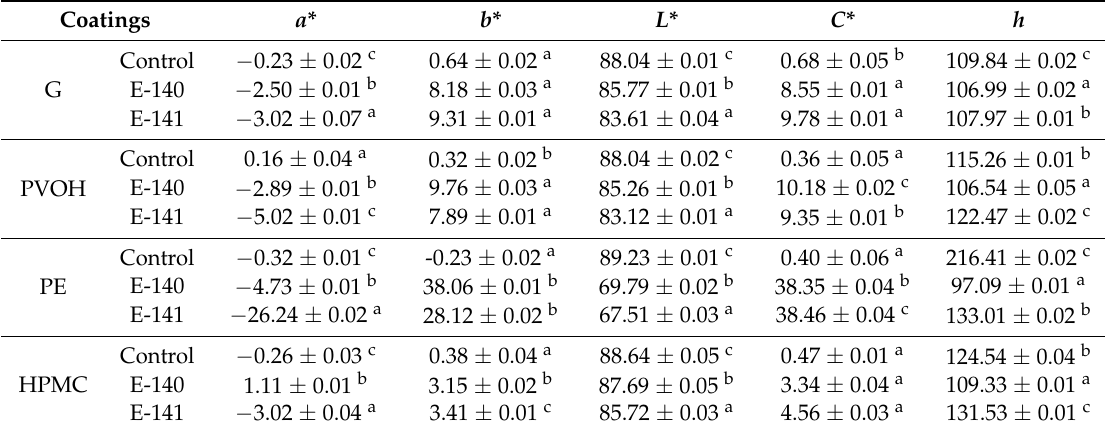
Table 4. Color coordinates L *, a *, b *, chromaticity ( C *) and tone ( h in ◦ ) of films coated with gelatin (G), polyvinyl alcohol (PVOH), polyethylene (PE), (hydroxypropyl)methyl cellulose (HPMC) without (control) and with active agents (E-140 and